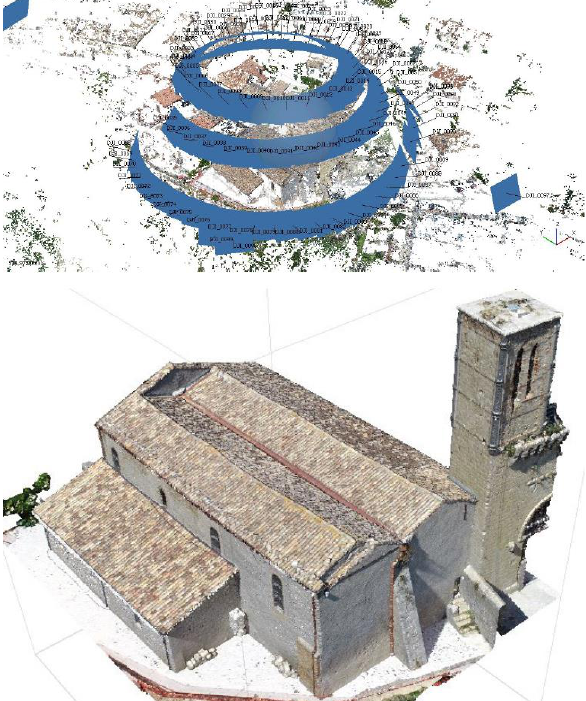
Figure 3 . UAV digital survey and SfM point cloud.